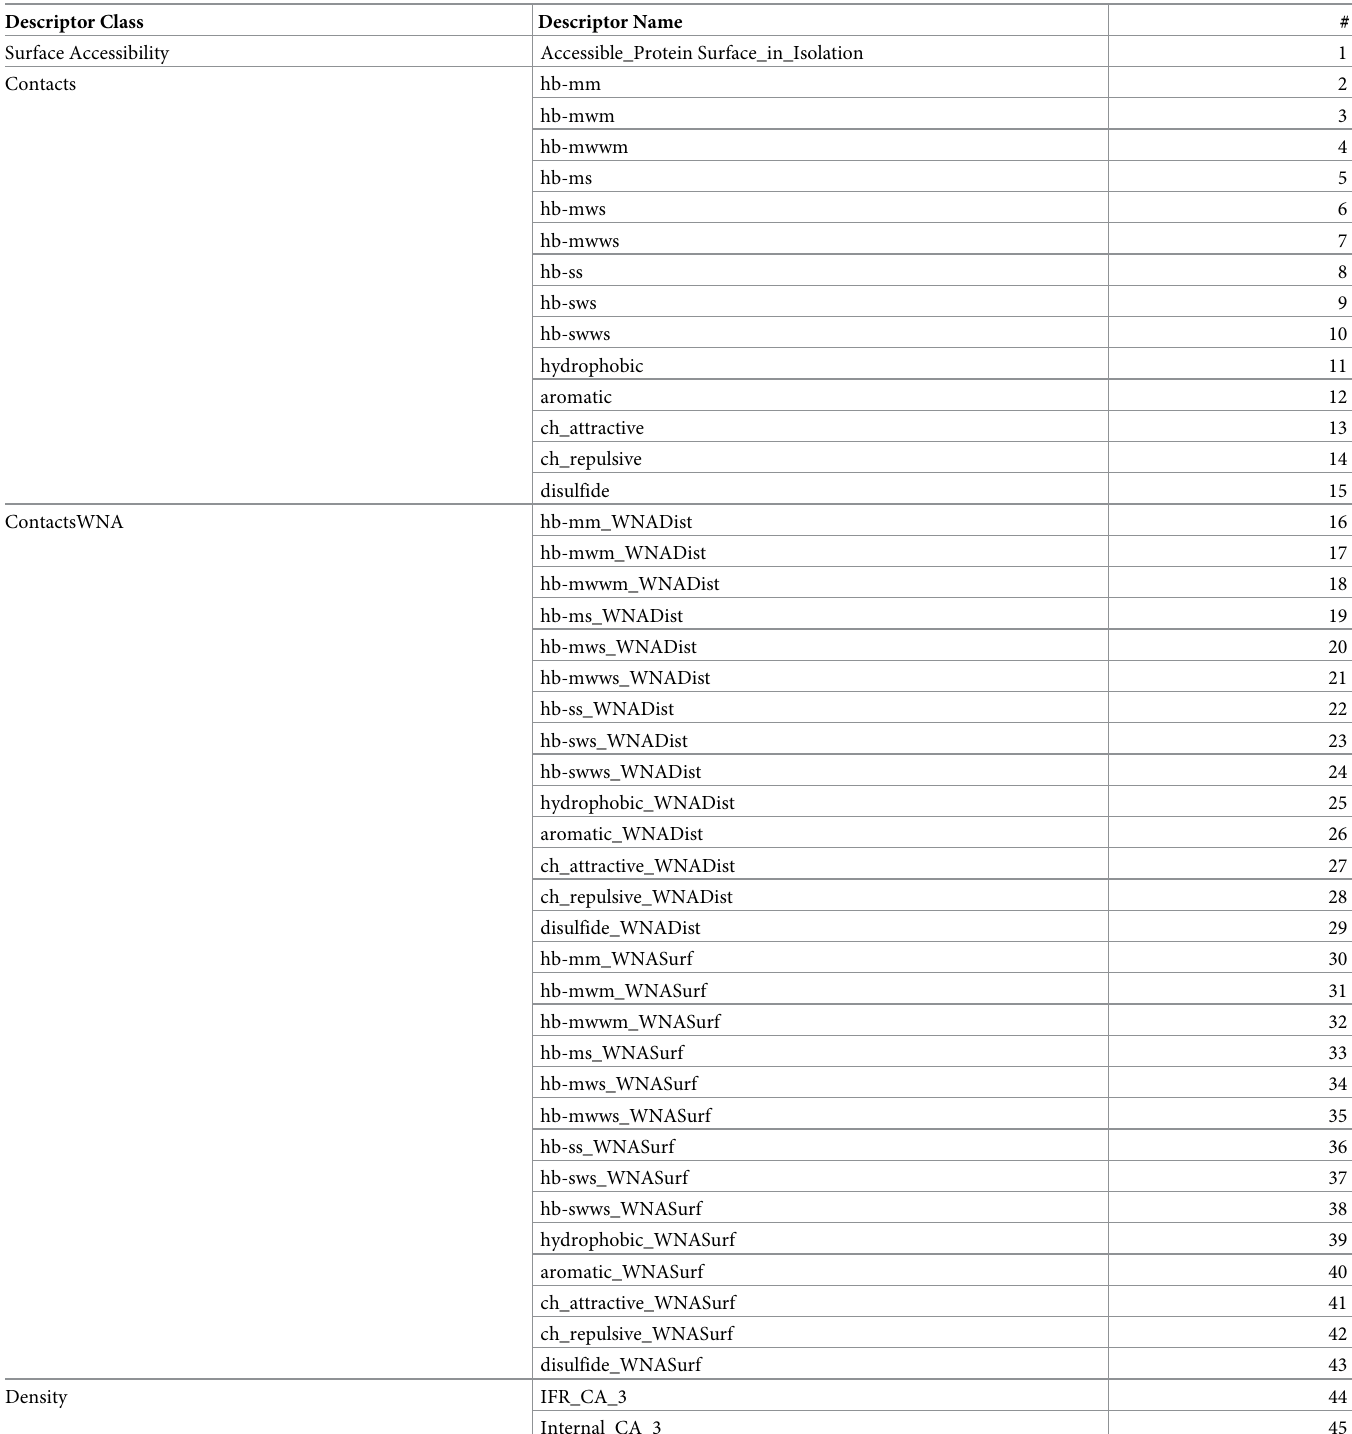
Table 1. STING_RDB descriptors used for the statistical analysis of the β sheet